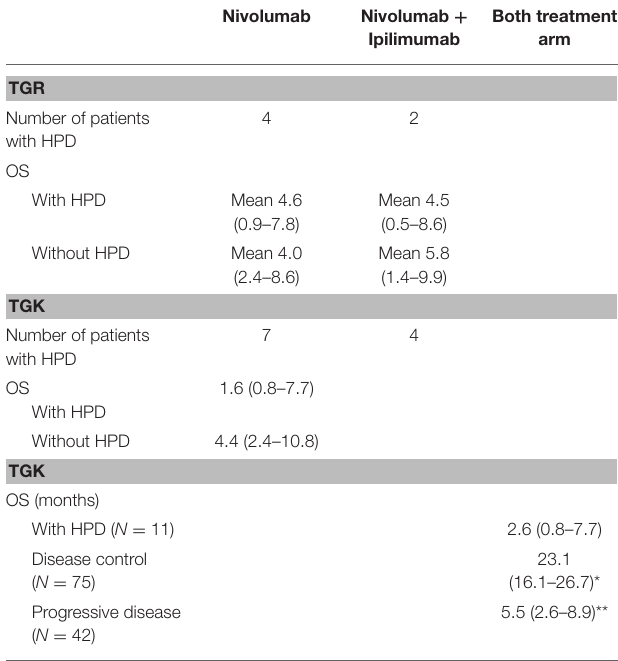
TABLE 2 | Hyper Progression Disease reported in the MAPS2 trial